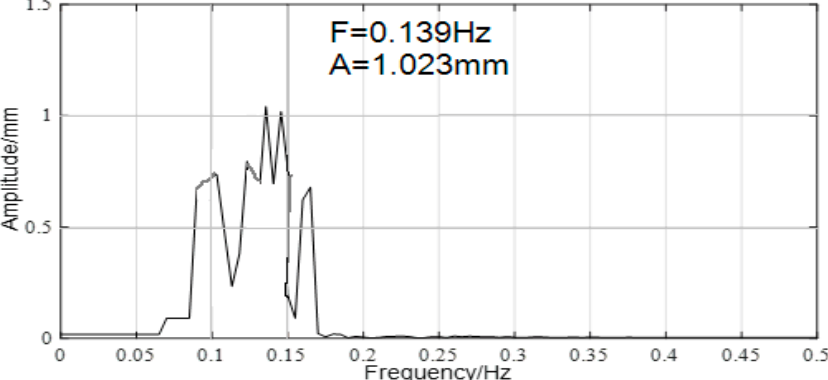
Figure 17. Hilbert time spectrum of the denoised observation sequence in the vertical direction.